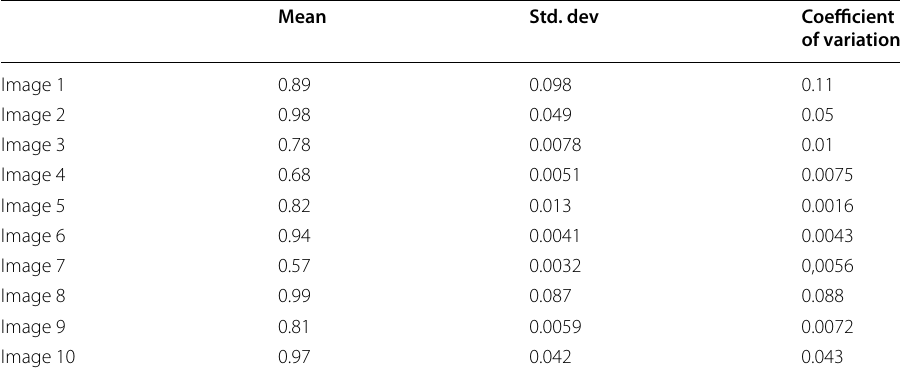
Table 6 Mean, standard deviation, and coefficient of variation of CNN probabilities for five different random cuts. For each image, the standard deviation is small. Therefore, the CNN results are independent of the random